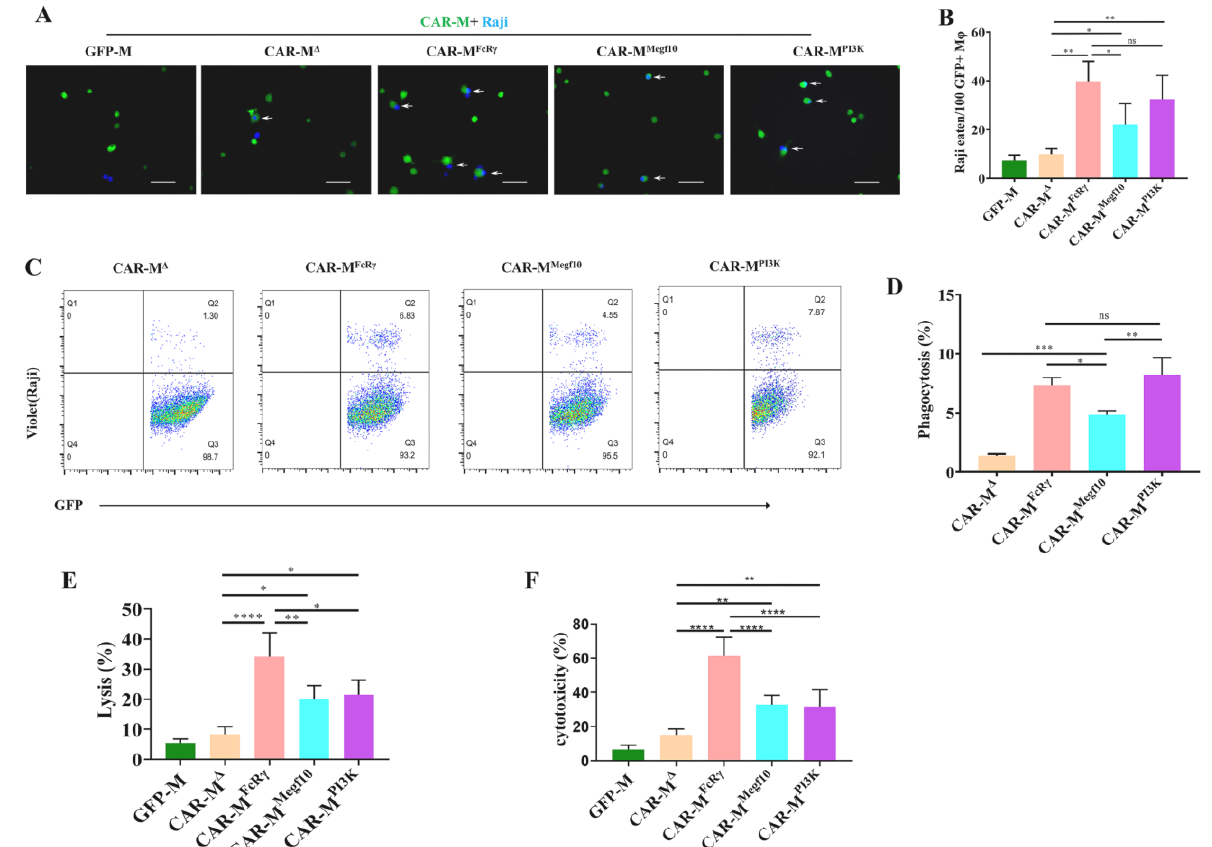
Figure 2. The comparation of phagocytic and killing capacity of different CAR-Ms. ( A ) Phagocytosis of Raji by different CAR-Ms was assessed using fluorescence microscopy. Scale bars, 50 μm; CAR -M, green; targets, blue. Photographs are representative of six. ( B ) Graph depicts pooled data from phagocytosis photographs of panel ( A ). The results are presented as the number of Raji eaten by 100 GFP+ macrophage (Mφ). All data are means ± SD, n =6. ( C ) Phagocytosis of Raji by different CAR-Ms was assessed using flow cytometry. Plots are representative of three. ( D ) Graph depicts pooled data from panel ( C ). Quantification of phagocytosis of Raji cells by flow cytometric analysis ( n =3). ( E ) Luciferase-based killing assay of Raji cell by GFP-M control or CAR-Ms at 48 h. Data represent the mean ± SD of n =3-4 biological replicates. ( F ) FACS counting-based killing assay of Raji by GFP-M control or CAR-Ms at 48 h. Data represent the mean ± SD of n =3 biological replicates. Statistical significance was calculated using one-way ANOVA (* p ≤ 0.05, ** p ≤ 0.01, *** p ≤ 0.001, **** p ≤ 0.0001) .